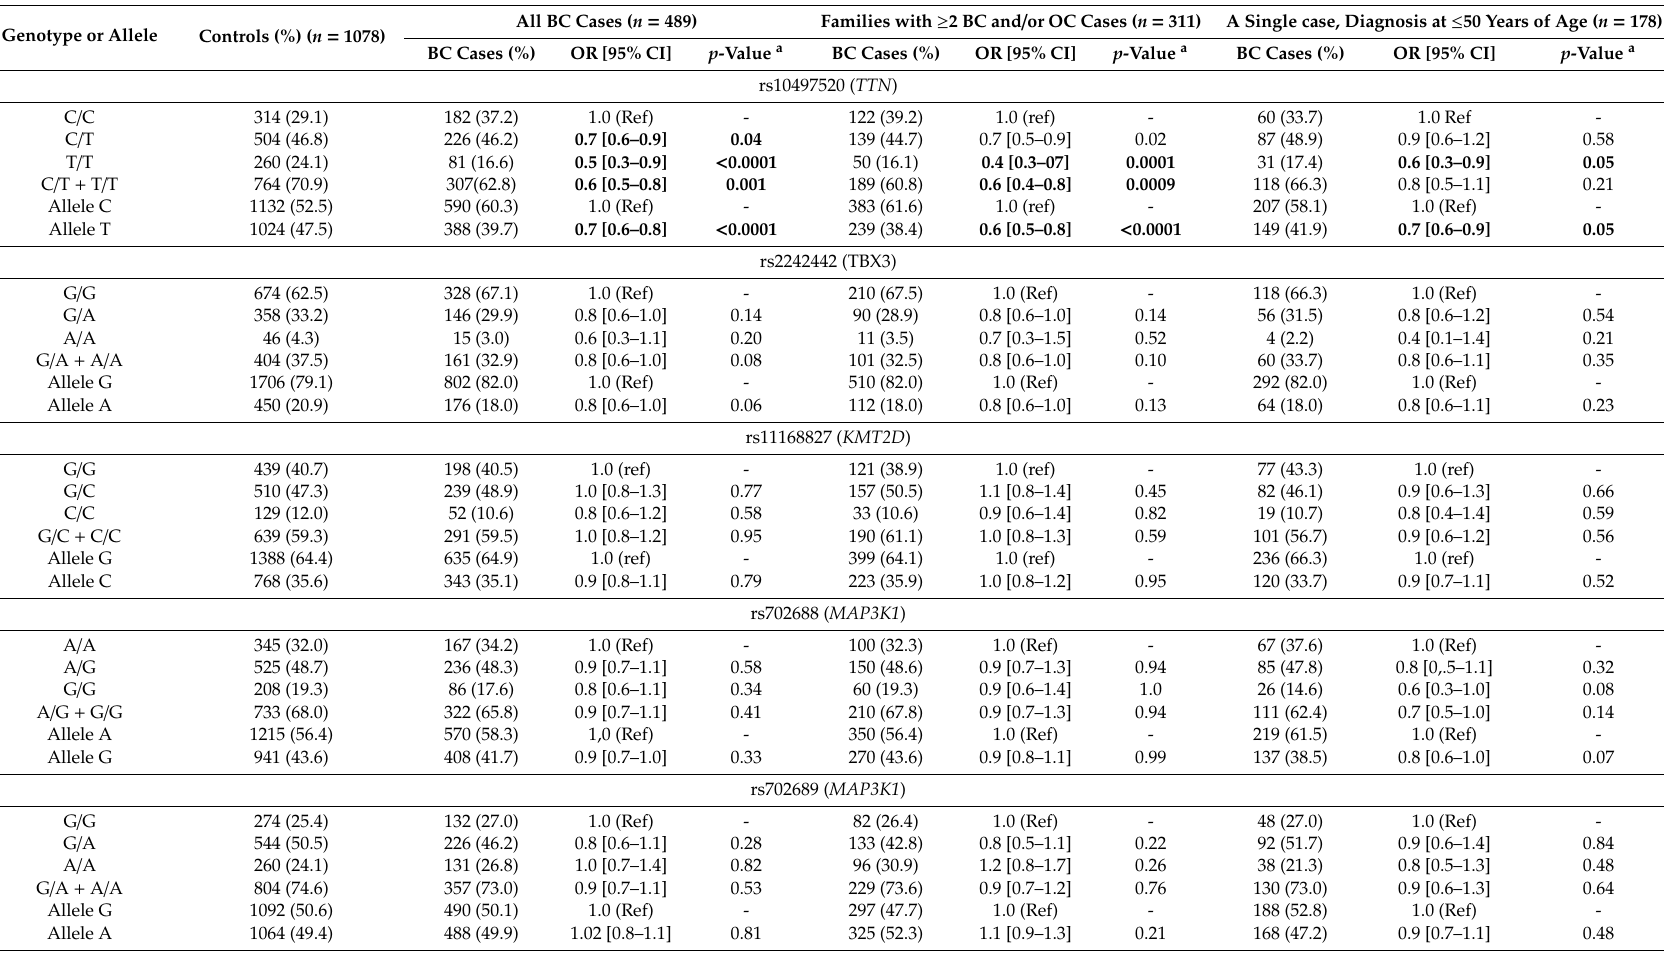
Table 1. Genotype and allelic frequencies of rs10497520 ( TTN ), rs2242442 ( TBX3 ), rs11168827 ( KMT2D ), rs702688 and rs702689 ( MAP3K1 ) in BRCA1 / 2 -negative breast cancer cases and